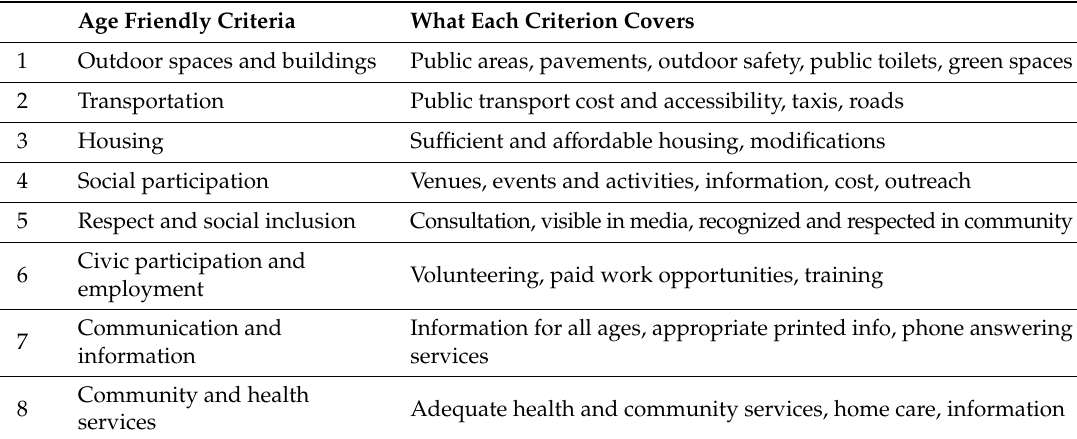
Table 4. World Health Organisation (WHO) age friendly cities